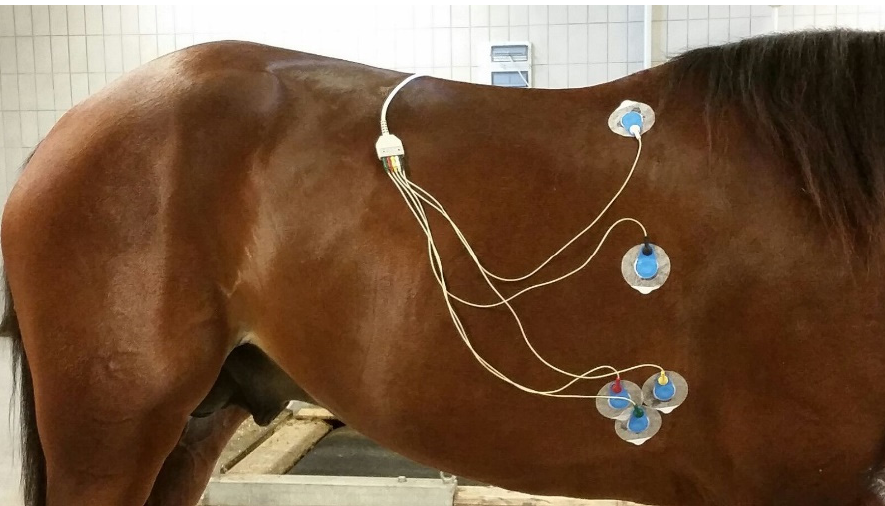
Figure 1. Positioning of the electrodes according to a modified base-apex configuration; reference electrode white; earth electrode black; exploring electrodes red, yellow, and green.